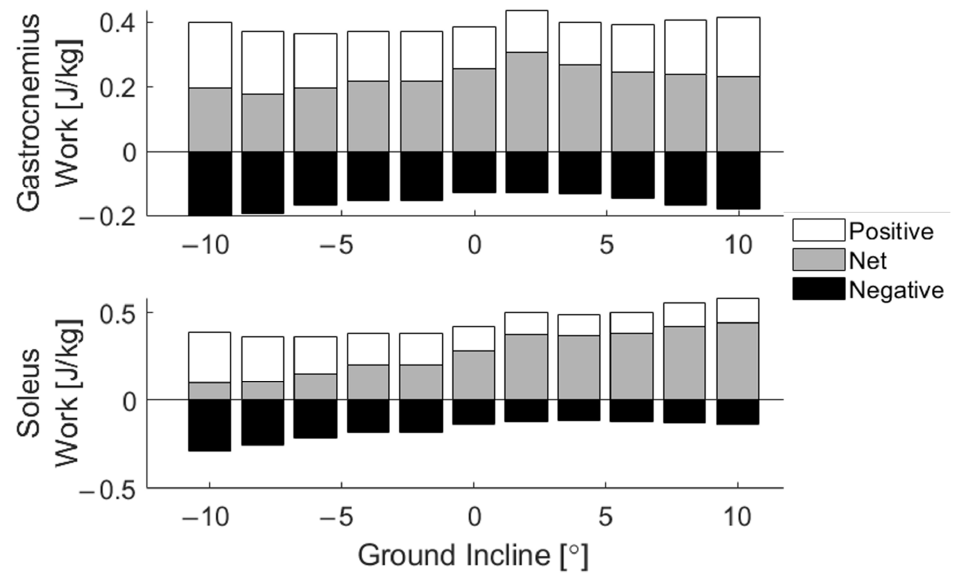
Figure 6. Zero-referenced positive, negative, and net work from each slope bin.